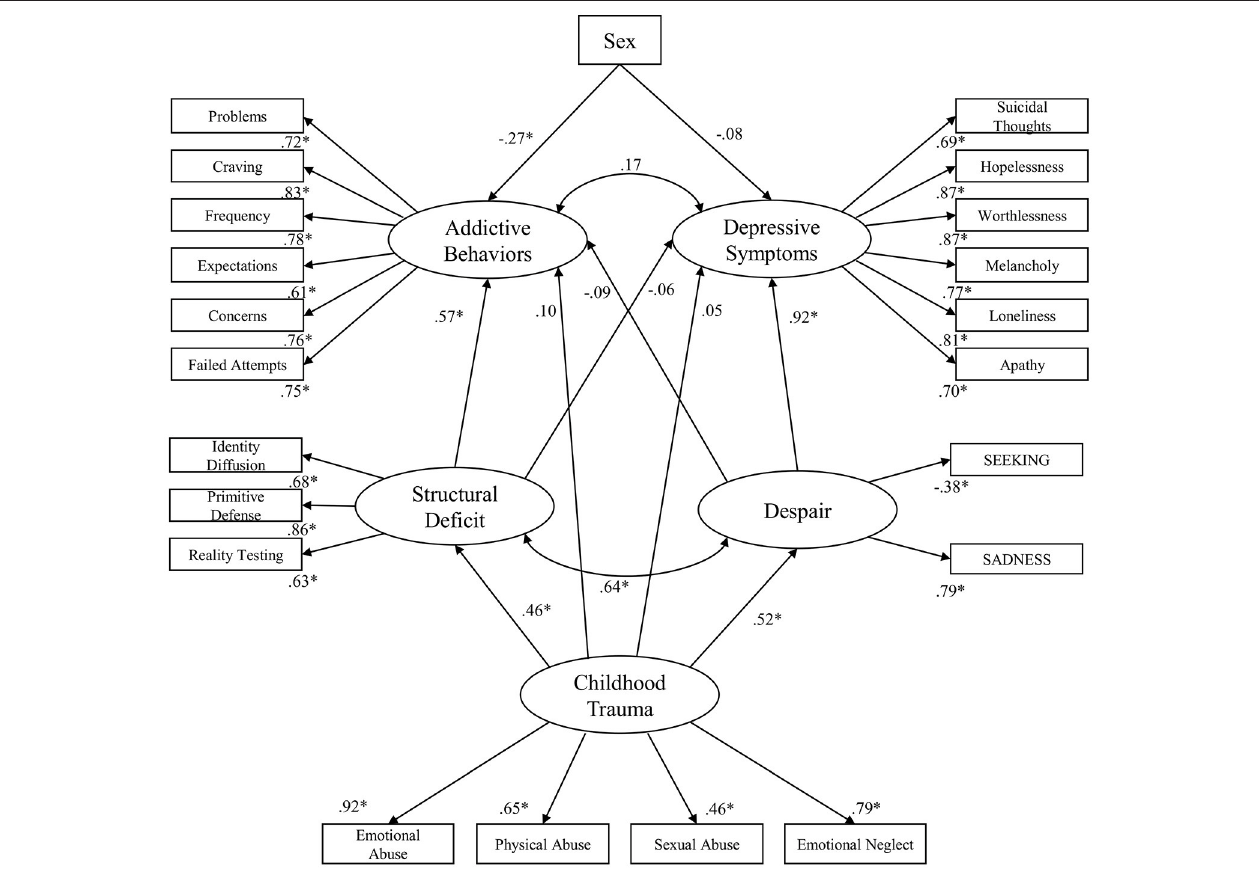
FIGURE 2 | Initial standardized solution for the structural equation model; * p < 0.001; Sex: Female = 1; Male =